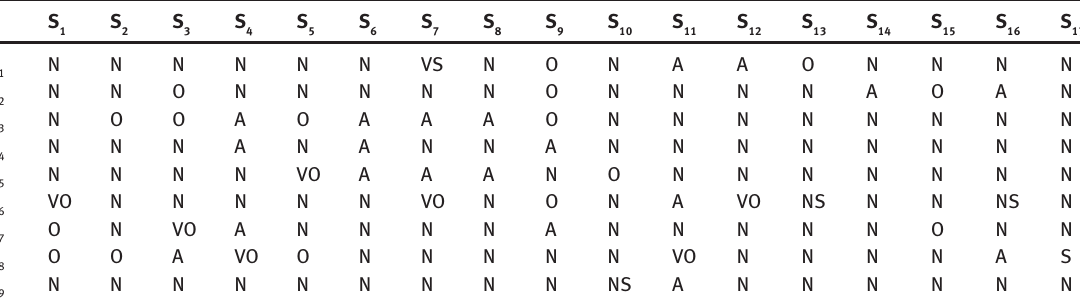
Table 1: Computation of Fuzzy Confirmability Relation Query: “How Strongly Does the Symptom “s” Confirm with Respect to the Disease “d”? (Case Study